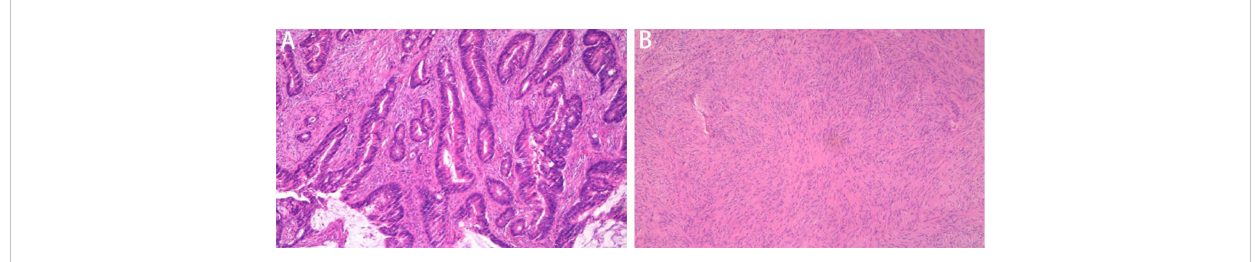
FIGURE 3 Photomicrographs. (A) Moderately differentiated invasive adenocarcinoma (hematoxylin and eosin, ×20 magni fi cation). (B) Small intestinal tumor consisting of fasciculate spindle cells (hematoxylin and eosin, ×40 magni fi cation).